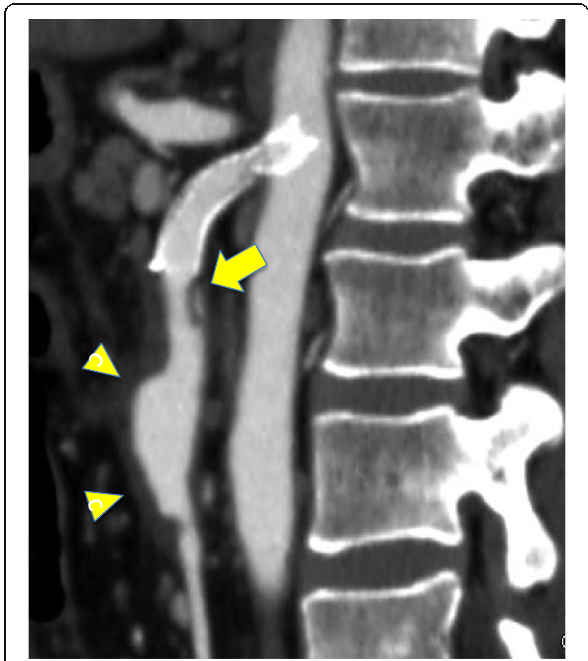
Fig. 4 Computed tomography image at 91 days postoperatively. The true lumen of the superior mesenteric artery was dilated at the patch angioplasty site (arrowheads), the stent was patent, and a small area lacking contrast medium was present at the remaining flap